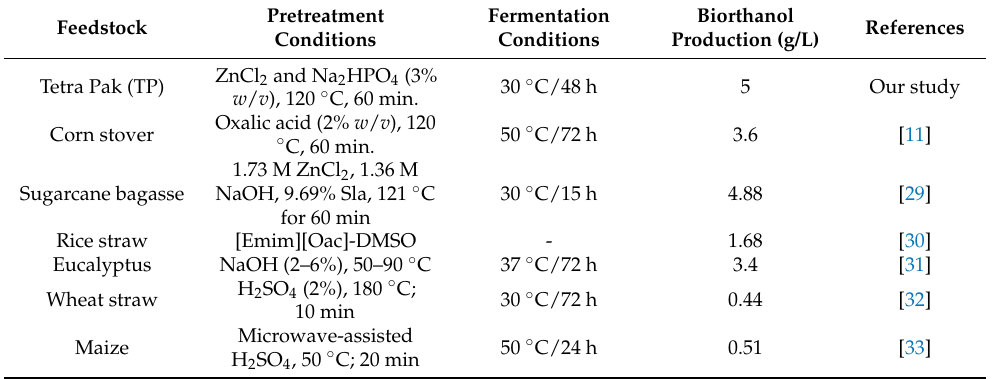
Table 2. Comparison of ethanol production of various feedstocks pretreated with various pretreat- ment